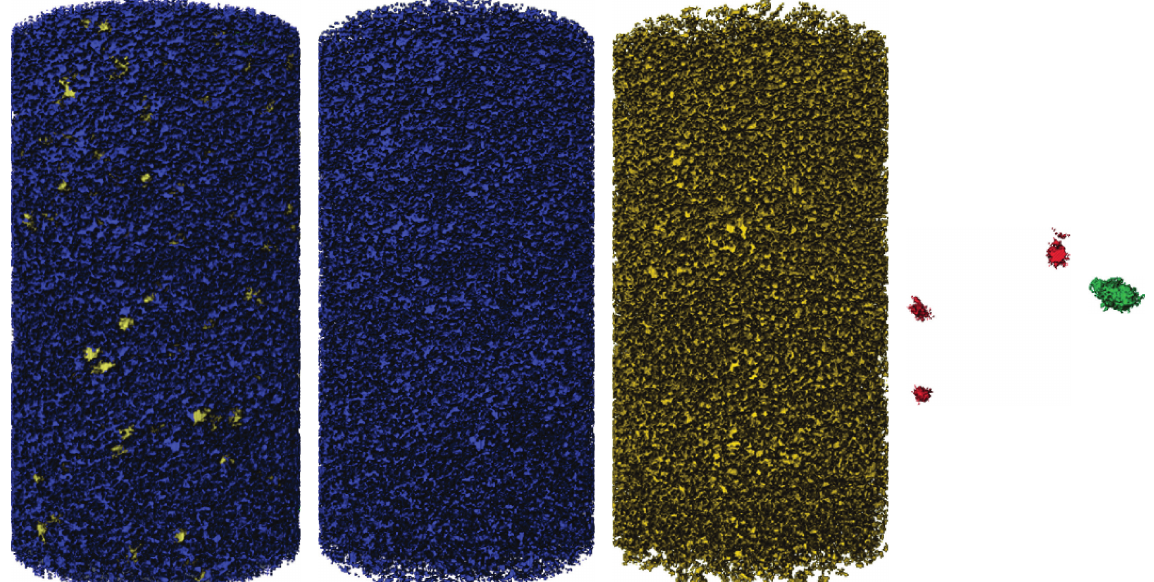
Figure 10: Spatial distribution of the pore structure of sample E-S-3.